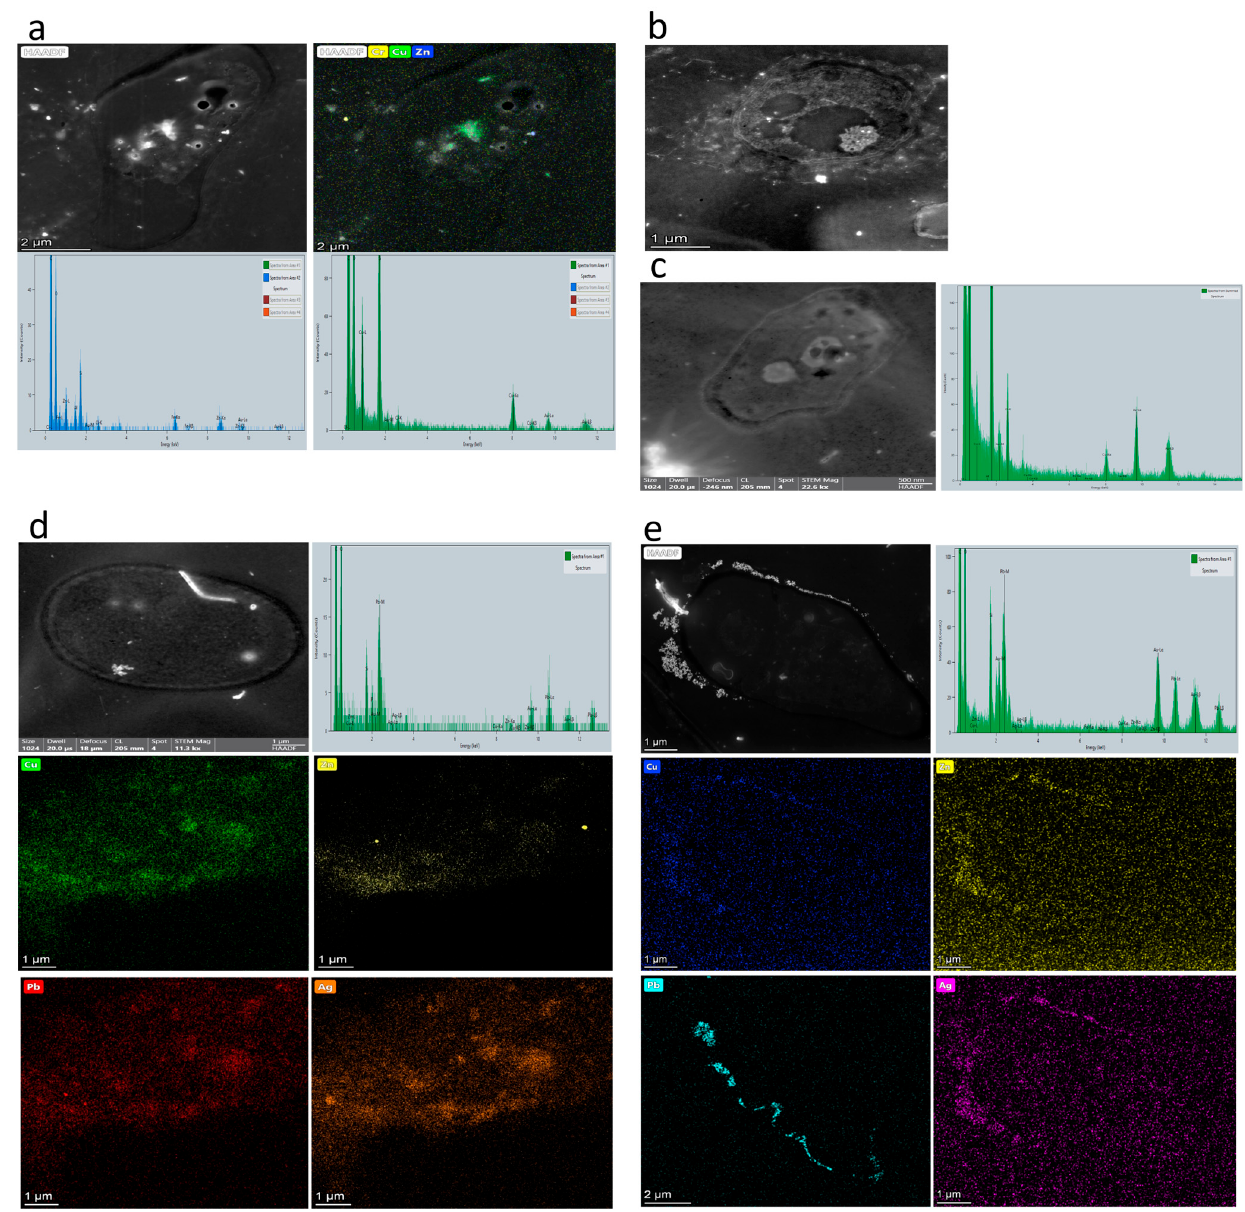
Figure 4. TEM of the five fungal strains in the presence of a multi-metal cocktail after 9 days of incubation. ( a ) C. maderasense , ( b ) C. jodhpurense , ( c ) P. variabile , ( d ) E. lacerata , and ( e ) P. betae in the presence of 20 mg/L of each Cu, Zn, Pb, and Ag.